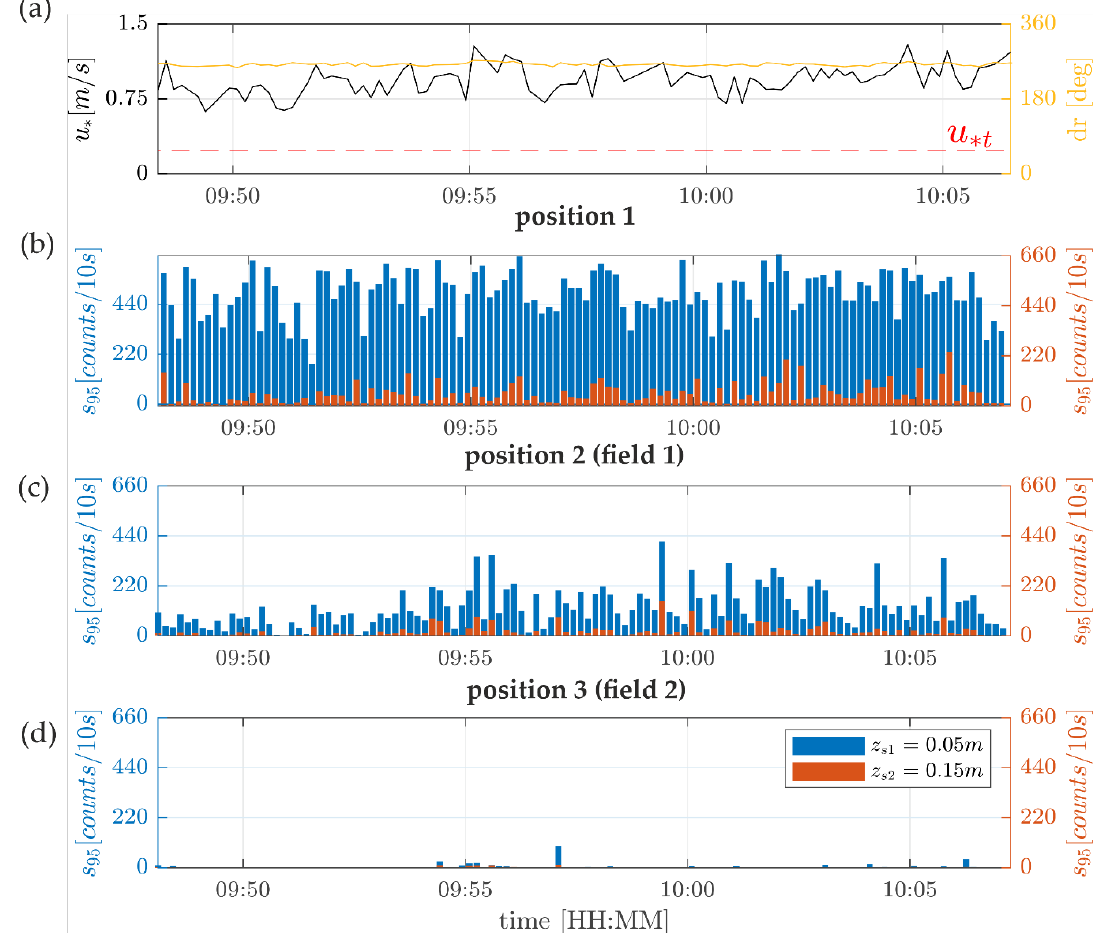
Figure 14. Time series of the ( a ) shear velocity, critical shear velocity, mean wind direction , and ( b , c , d ) 95% quantiles of saltation impacts over 10-s time intervals for the measurement location of the sand trapping fence conducted on 24 May 2020.